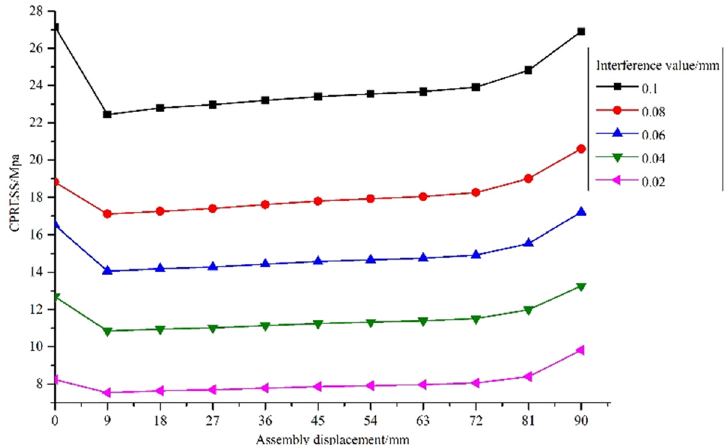
Figure 11: Distributions of CPRESS along the path at di ff erent interference values.